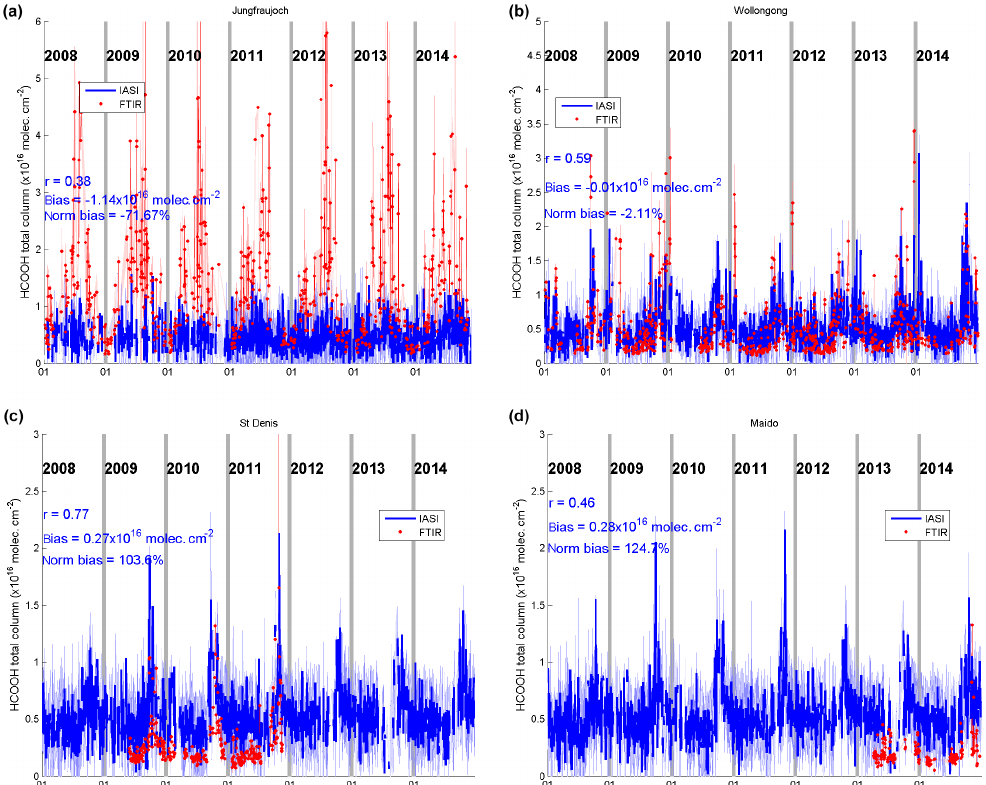
Figure 9. Time series of HCOOH daily means over Jungfraujoch (a) , Wollongong (b) , Saint-Denis (c) , and Maido (d) between 2008 and 2014 for IASI (blue) and the ground-based FTIR (red) measurements. The IASI data are collocated at ± 0.5 ◦ around the site location. The correlation coefficient, the mean bias, and the normalized mean bias for all years are given in blue font on each plot. The blue shade error bar corresponds to the standard deviation on the IASI daily means. The altitude of the stations is 3.6km for Jungfraujoch, 20m for Wollongong, 50m for Saint-Denis, and 2.2km for